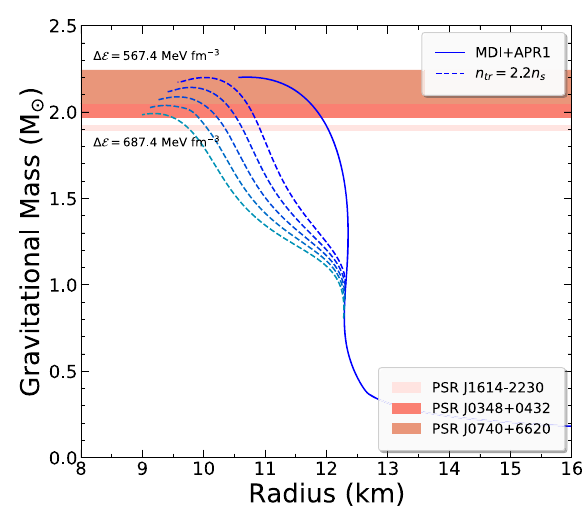
Figure 2. Mass-Radius diagram in the case of a sharp transition at n tr = 2 . 2 n s (dashed lines) for various values of the energy density jump Δ E . The solid line refers to the absence of a phase transition and is added for comparison. The coloured strips near the top of the figure denotes the range (uncertainty) around the maximum observed mass values of three pulsars